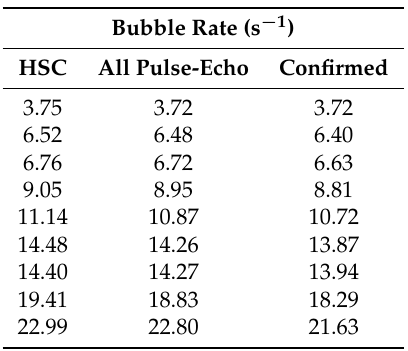
Table 2. Comparison of the number of bubbles passing the measurement volume as measured by the pulse-echo with tracking and the HSC.